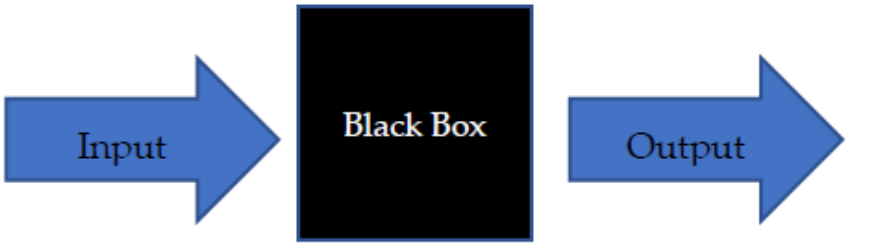
Figure A1. An example of mapping locations in the images to the pixel value as part of machine analysis of the picture.